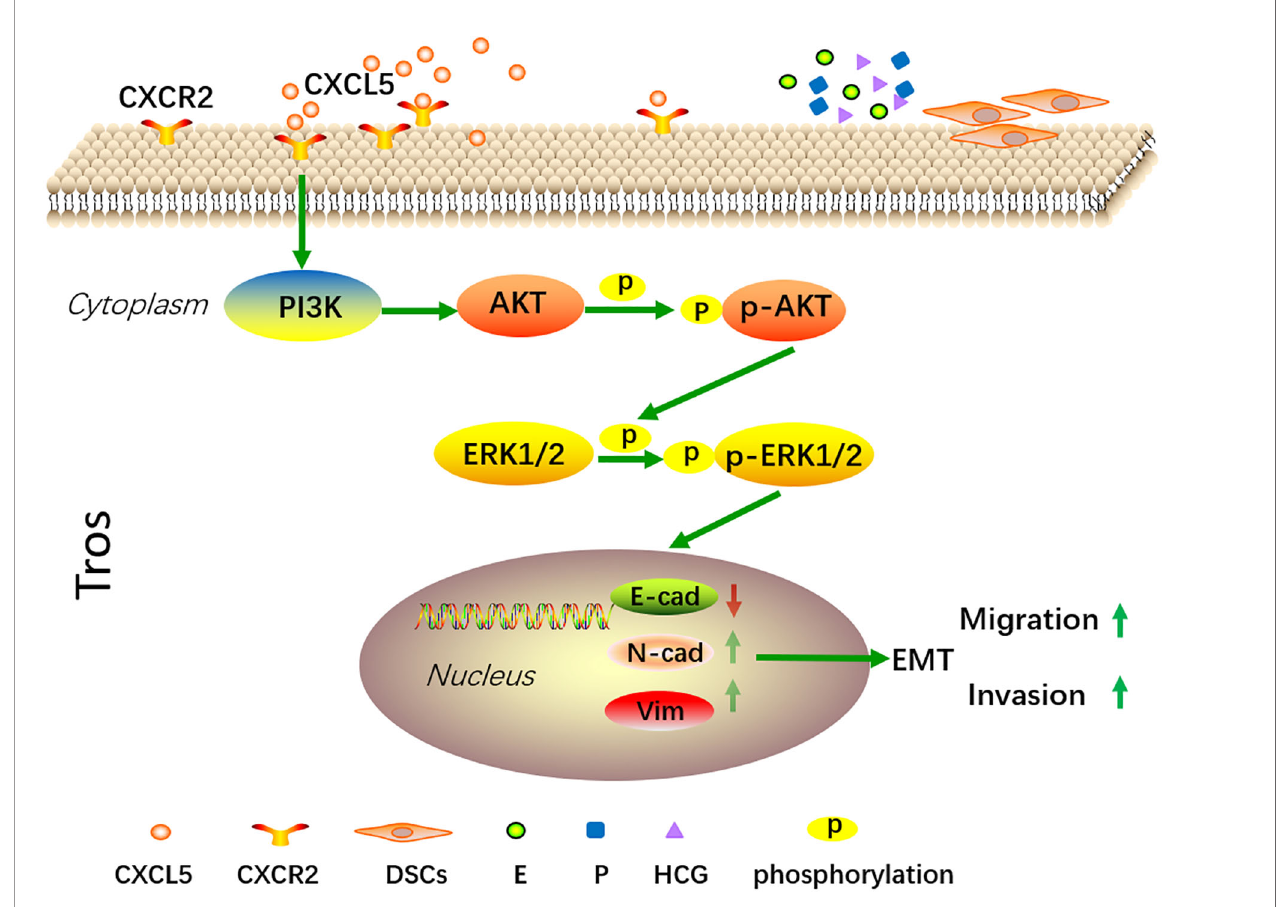
FIGURE 7 | A schematic diagram of CXCL5 promoting trophoblast migration, invasion, and EMT process through PI3K/AKT/ERK1/2 signaling pathway. Trophoblast cells express CXCR2, which is the receptor of CXCL5. Exogenous CXCL5 combined with CXCR2 promotes the EMT process through the activation of the PI3K/AKT/ERK1/2 signaling pathway and consequently increases the invasiveness and migration of trophoblast cells. Conversely, downregulation of CXCL5 results in insuf fi cient invasion and therefore is correlated with the pathology of RSA. In addition, E, P, HCG, and DSCs participate in regulating CXCL5 and CXCR2 expression of trophoblast cells within the microenvironment of pregnancy at the maternal – fetal interface. CXCL5, C-X-C motif chemokine ligand 5; EMT, epithelial-to- mesenchymal